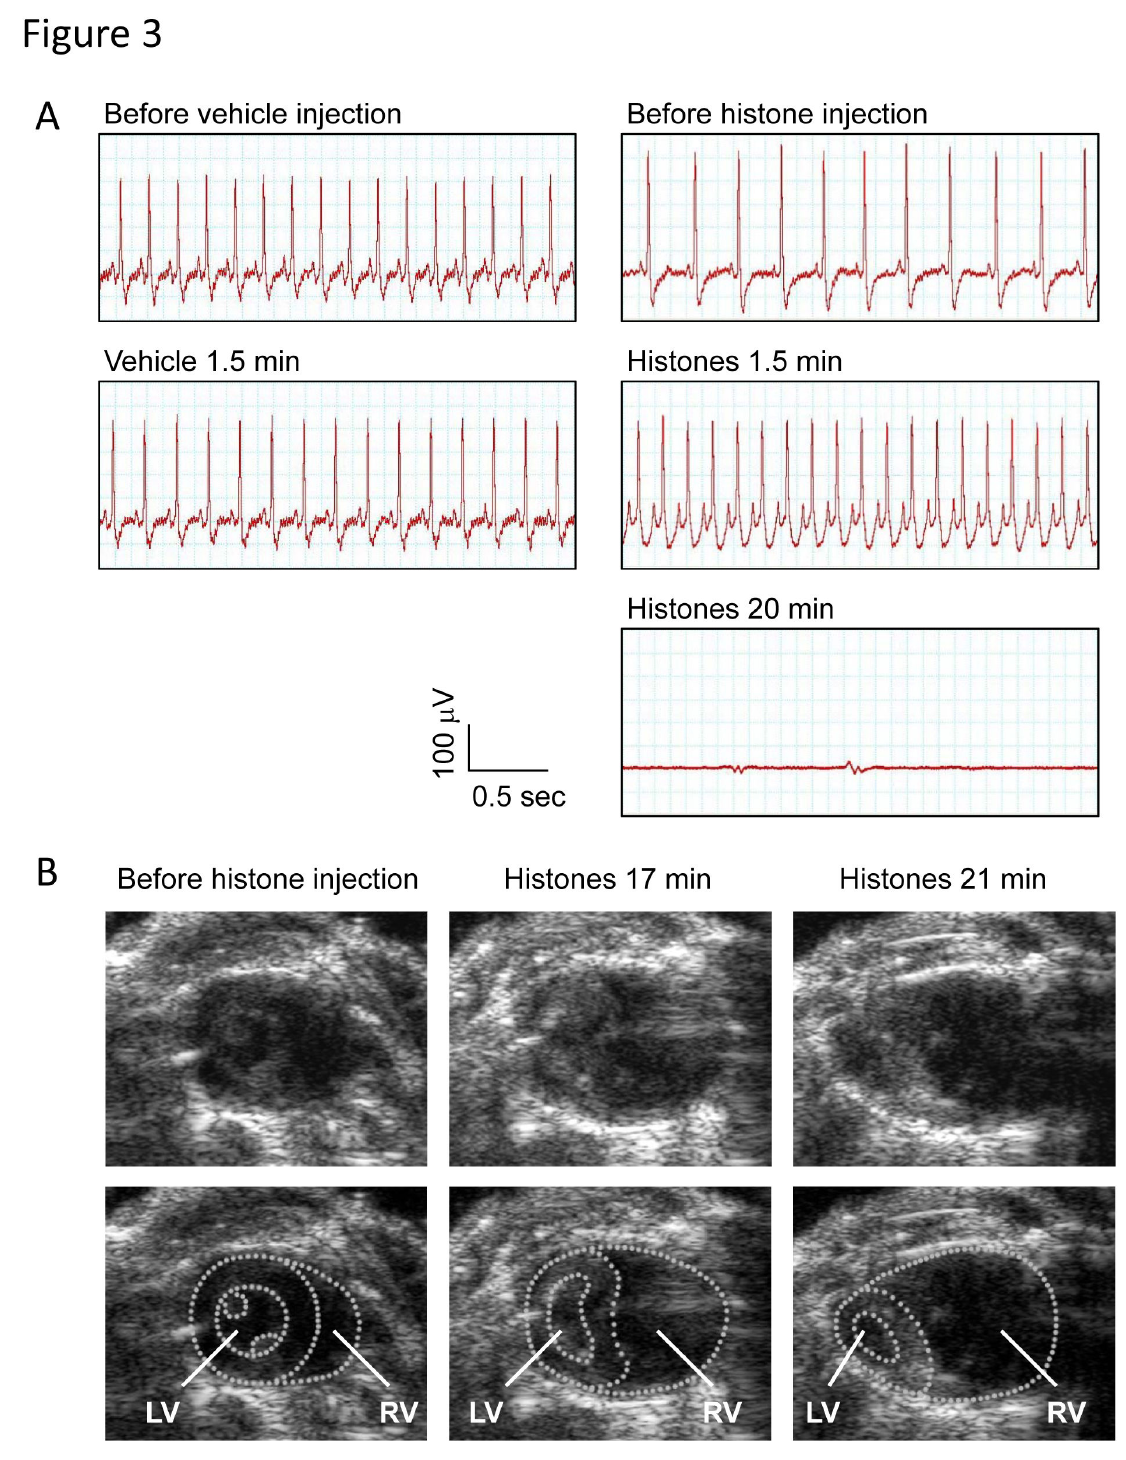
Figure 3. Extracellular histones cause acute right-sided heart failure and ventricular arrest. (A) ECG in mice intravenously injected with vehicle or histones (80 µg/g). The voltage between the right limb and the feet (lead II) was recorded. Data presented are representative of three independent experiments. (B) Still images from Movies S1-S3. Transthoracic echocardiography was performed in mice before and after intravenous injection of histones. Extracellular histones caused dilatation of the right ventricle (RV) and displacement of the interventricular septum toward the left ventricle (LV). doi: 10.1371/journal.pone.0075961.g003 PLOS ONE |